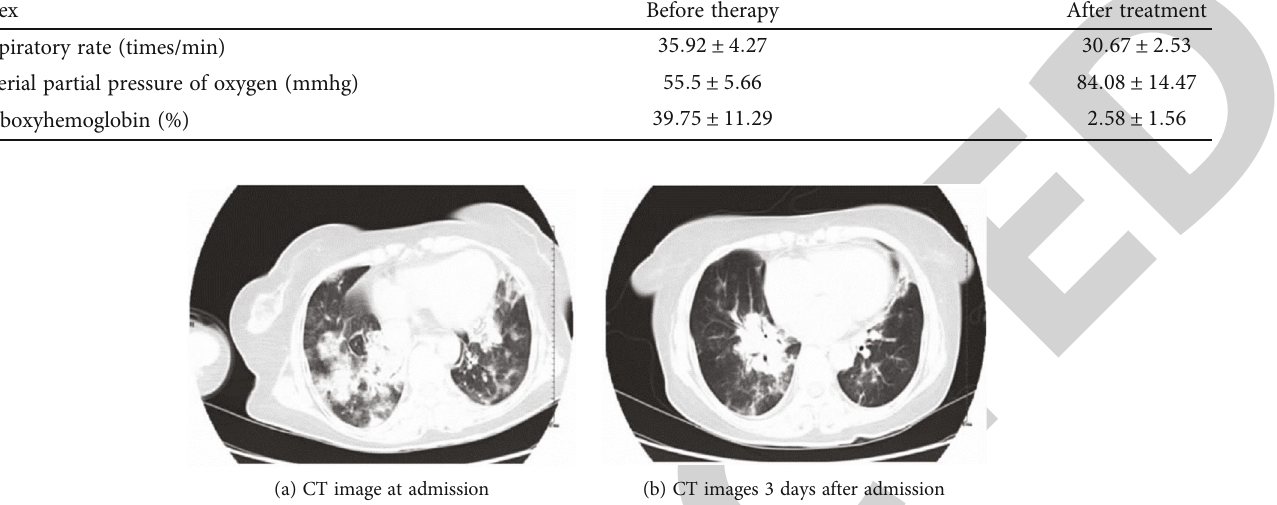
Table 1: Changes of respiratory rate, arterial oxygen partial pressure, and carboxyhemoglobin before and after treatment ( (cid:1) x ± s , n = 12 in each group).